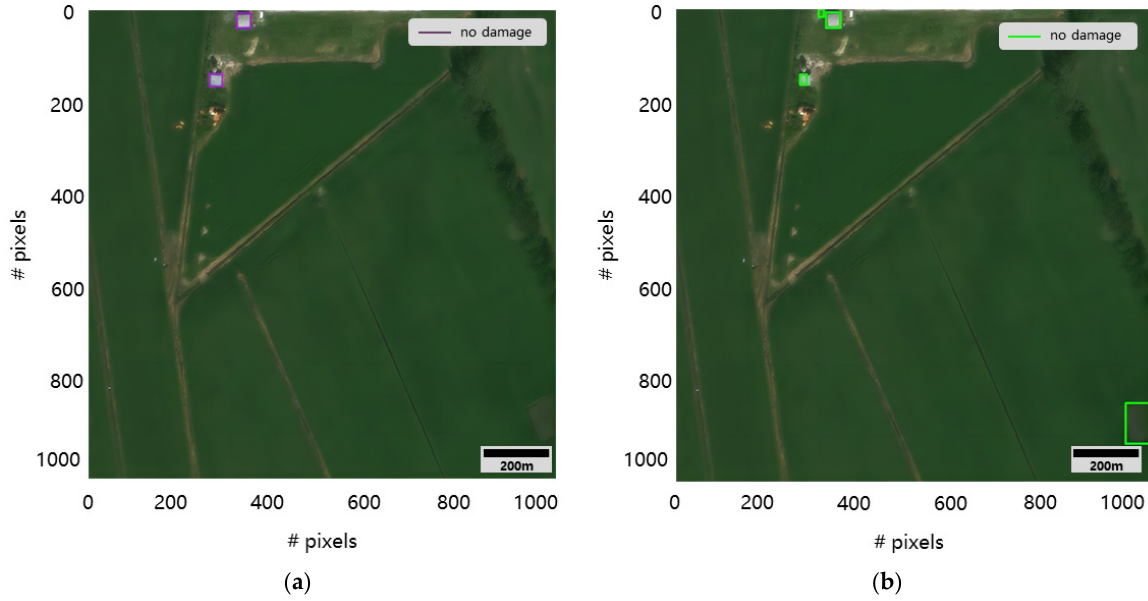
Figure 11. YOLOX and SegDetector detection results ( a ) is the YOLOX detection result and ( b ) is the SegDetector detection result.